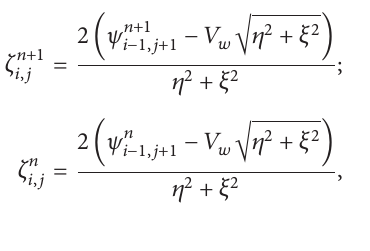
𝑉 = +𝑈 𝑈 𝑤 0 (b, d), 0 is punching velocity, and the dimensional